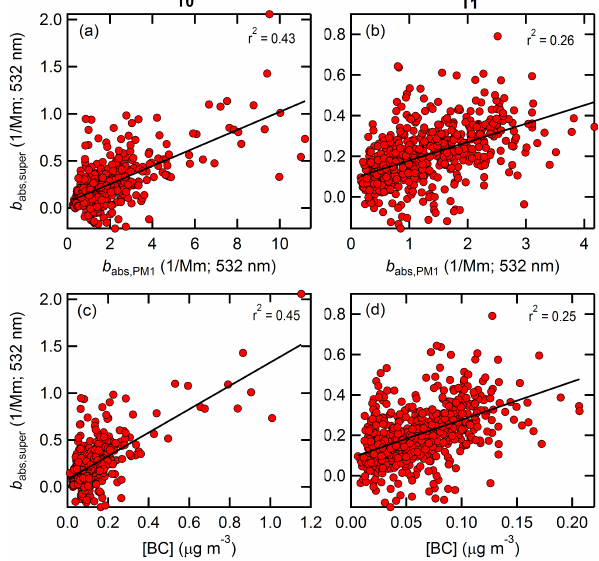
Figure 6. Covariation of the supermicron absorption at T0 (left pan- els) and T1 (right panels) with the submicron absorption (top pan- els) and with black carbon concentration (bottom panels). Note that negative values of b abs,super result from this being derived from the difference between b abs,PM and b abs,PM 10 1